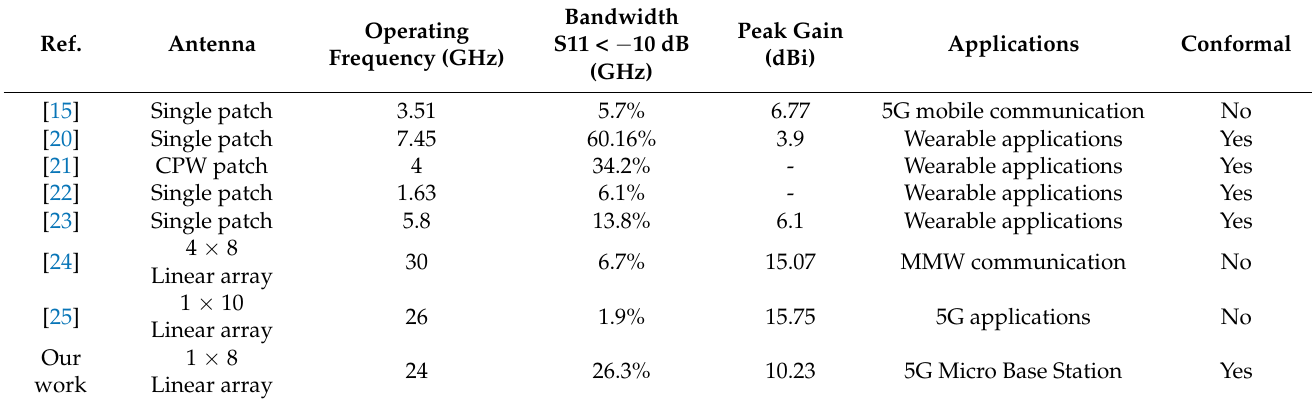
Table 3. Comparison of recently published antennas based on graphene